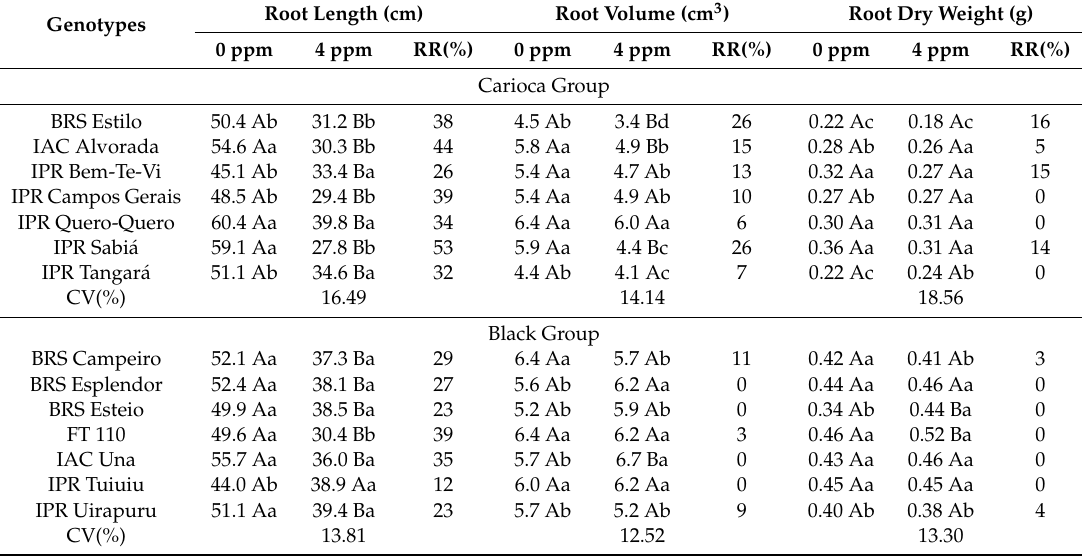
Table 3. Common bean cultivars of Mesoamerican origin, market classes carioca and black, grown in Al-free and Al-contaminated nutrient